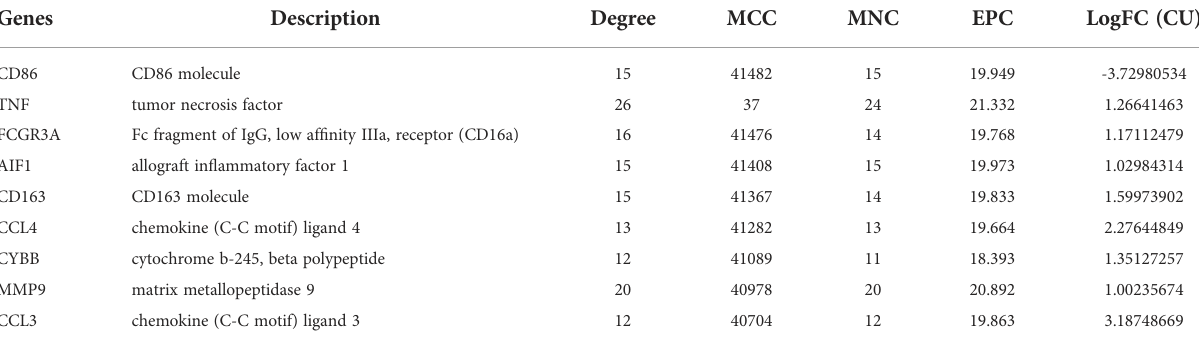
TABLE 3 The hub